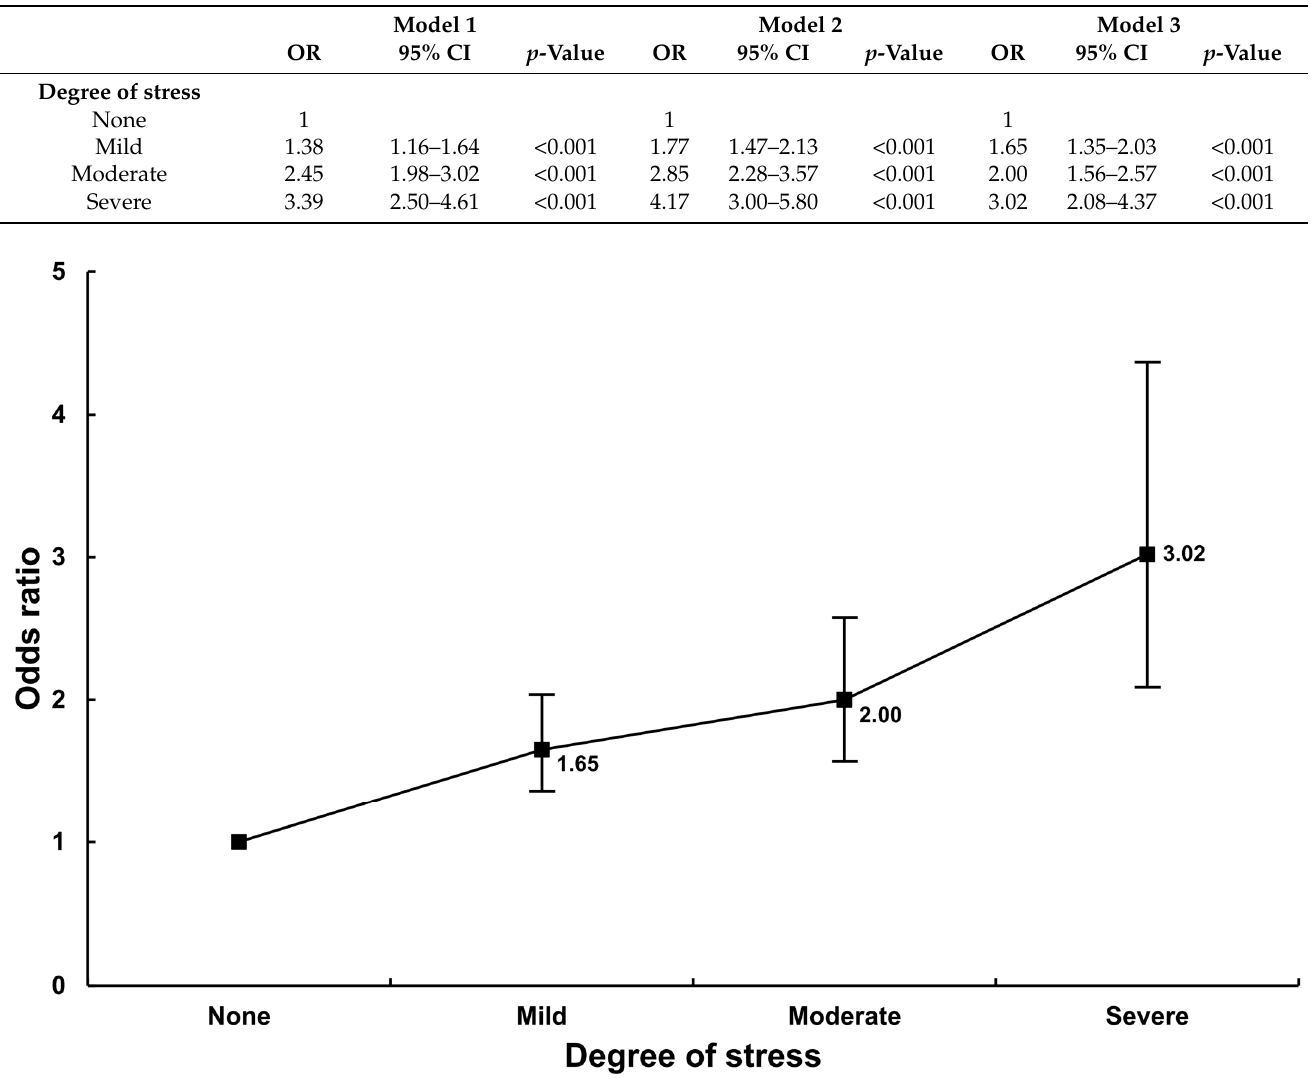
Figure 2. Association between CKP and psychological stress. The model was adjusted for age, sex, and other factors including obesity, the duration of sleep, smoking status, education level, alcohol consumption, household income, occupation, physical activity level, and comorbidities.